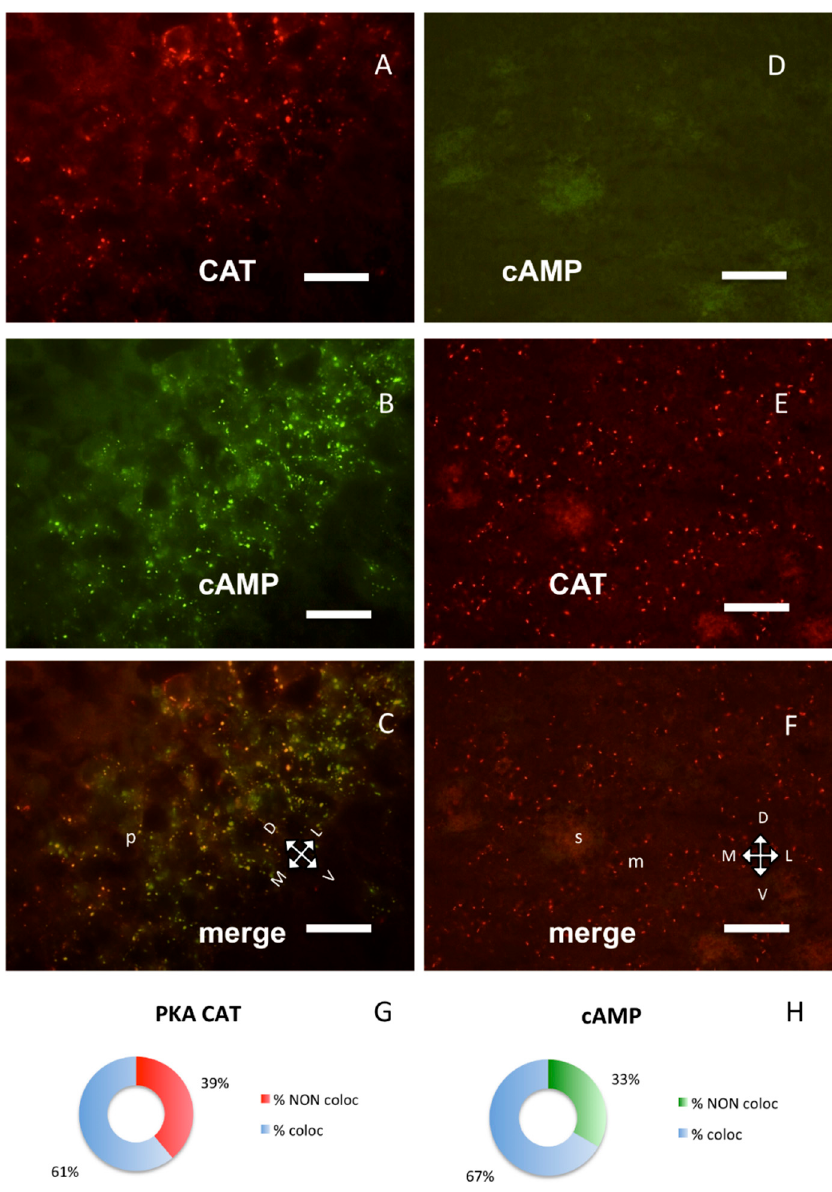
Figure 3. PKA catalytic subunit in hippocampus and corpus striatum, coronal sections. ( A ) Catalytic subunit immunolabeling in the pyramidal layer of CA1b subfield of hippocampus, dorsal on upper left. ( B ) Same field, Alexa488-cAMP. ( C ) Merge of A and B , showing partial colocalization of the two signals; p : pyramidal layer. ( D ) In the corpus striatum, no labeling can be observed with Alexa488-cAMP. ( E ) Catalytic subunit immunolabeling in the same field. ( F ) Merge of D and E . D – F : Dorsal on the top; m: matrix, s: striosomes. Scale bar, 10 µ m ( A – C ), 25 µ m ( D – F ). G , H : Quantification of superimposition in C ( n = 1426). ( G ) Percentage of colocalization of PKA catalytic immunolabeling (% coloc, light blue, n = 364) or not (% NON coloc, red, n = 233) with cAMP in C . ( H ) Percentage of colocalization of cAMP (% coloc, light blue, n = 477) or not (% NON coloc, green, n = 239) with PKA catalytic immunolabeling in C .